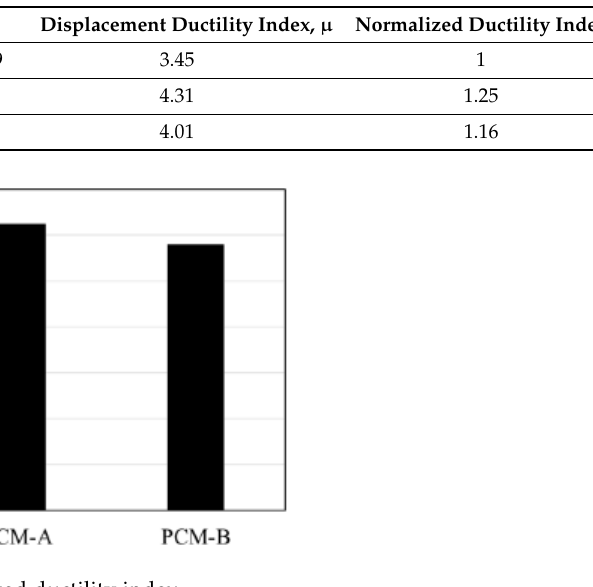
Figure 18. Comparison of normalized ductility